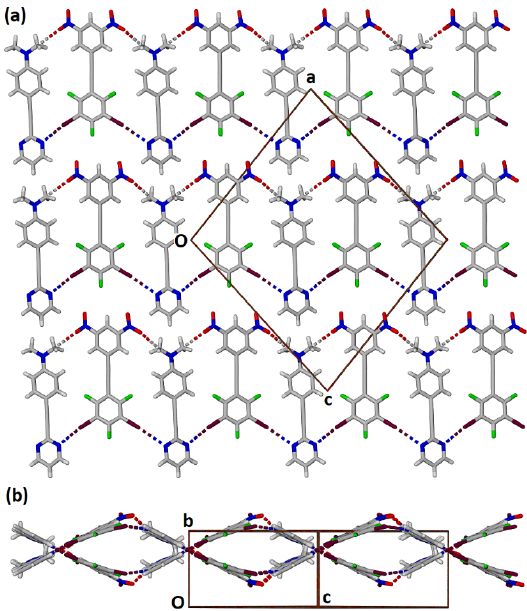
Figure 12. Two views of adjacent alternately corrugated halogen bonded ribbons in the cocrystal 2•3 with halogen bonds and tetral bonds shown as dashed lines. ( a ) View along the b axis and ( b ) view along the line 1 0 −